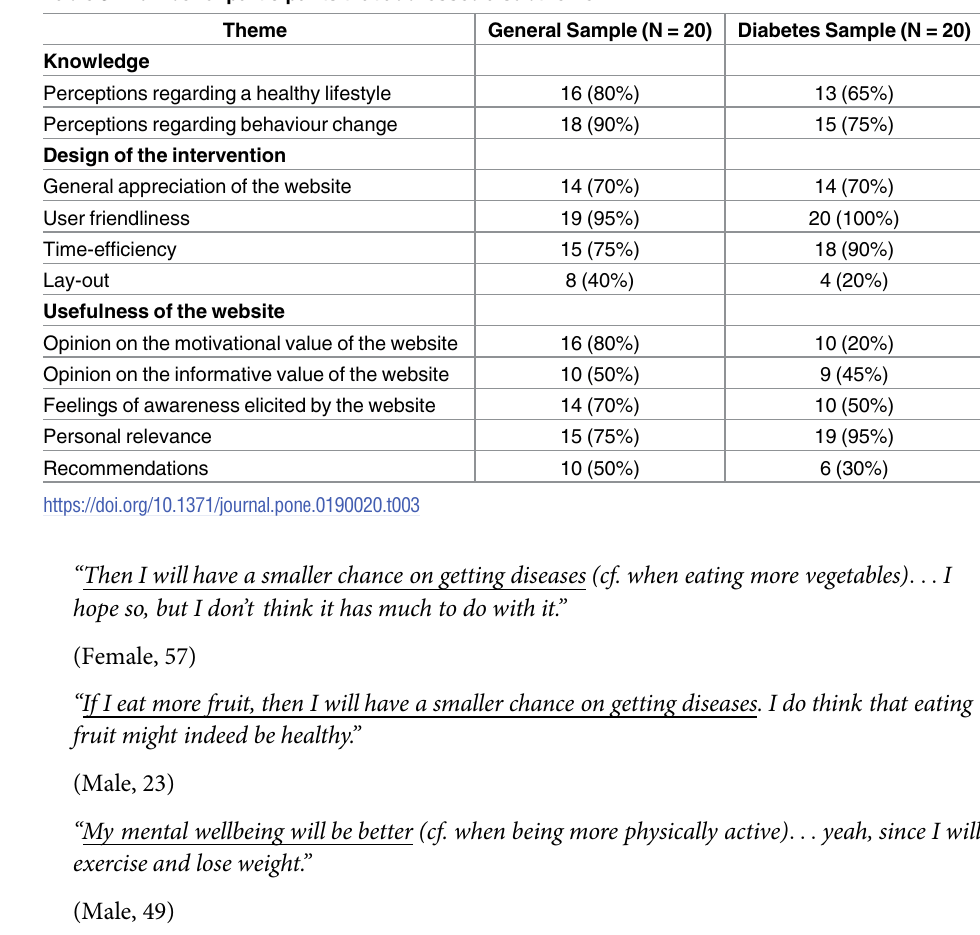
Table 3. Number of participants that addressed a